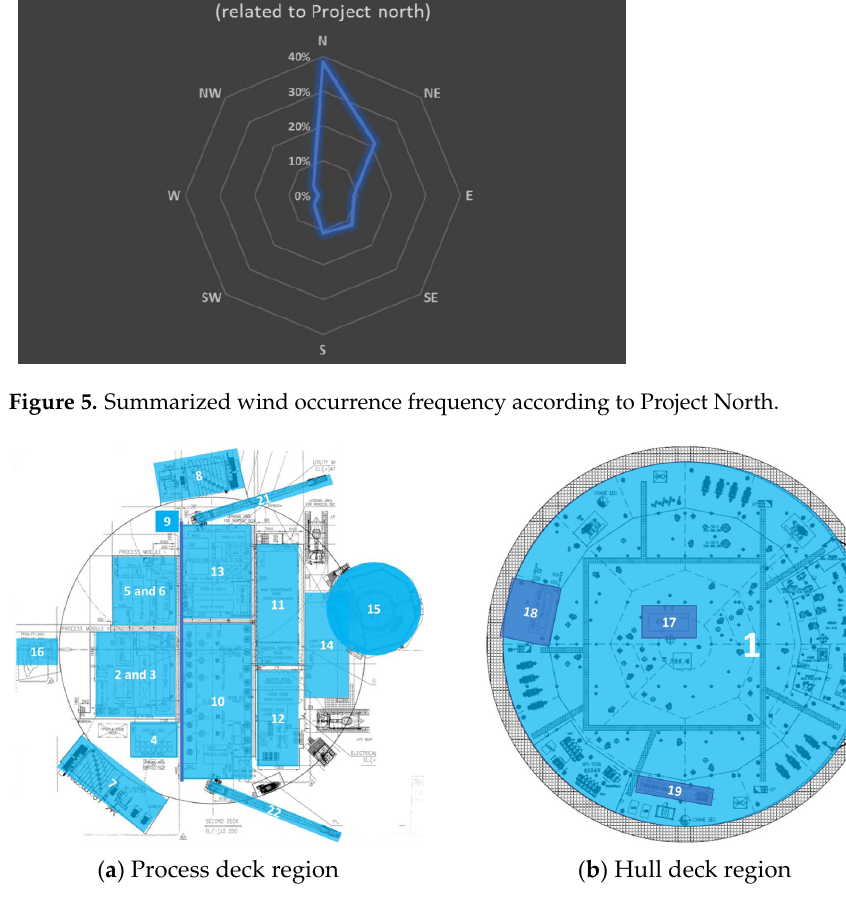
Figure 6. Regions defined for probabilistic explosion and fire analysis. ( a ) shows the process deck region with process module and deck, offloading starboard and portside, firewall, power-generation module, electrical module, utility module, living quarter, helideck, base of flare tower, crane portside and starboard; ( b ) shows the hull deck region with closed drain area, flare KO drum area and risers.